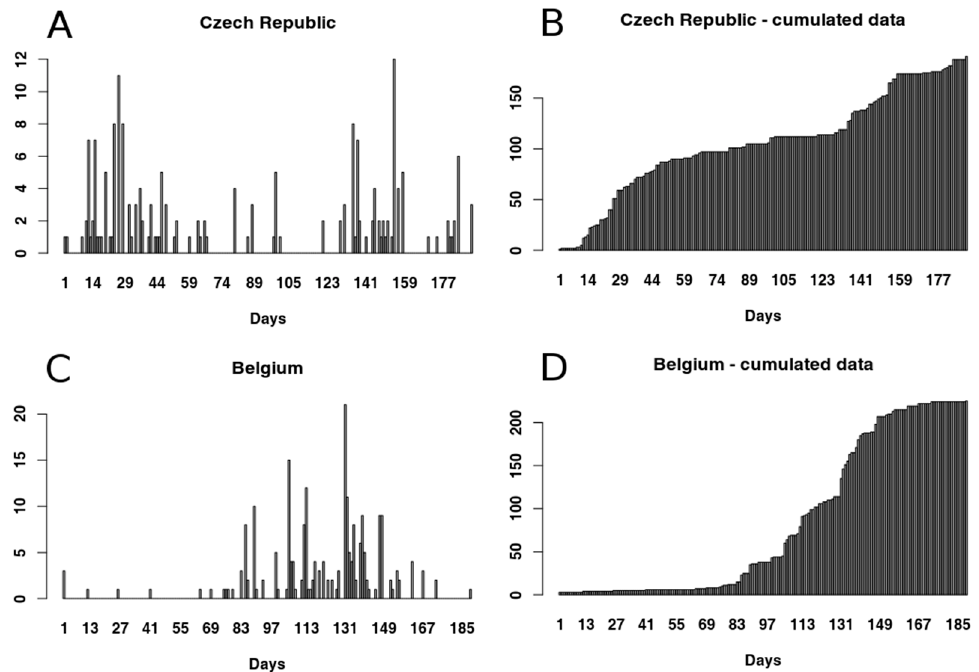
Figure 1. Data sets: ( A ) number of carcasses found in Czech Republic, Zlin area; ( B ) cumulated number of carcasses found in Czech Republic, Zlin area; ( C ) number of carcasses found in Belgium, Virton Forest; ( D ) cumulated number of carcasses found in Belgium, Virton Forest.